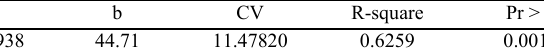
Table 4: Simple regression parameter between BD and soil moisture (SM) Equation a b CV R-square Pr > F Y= -18.938 BD+ 44.71